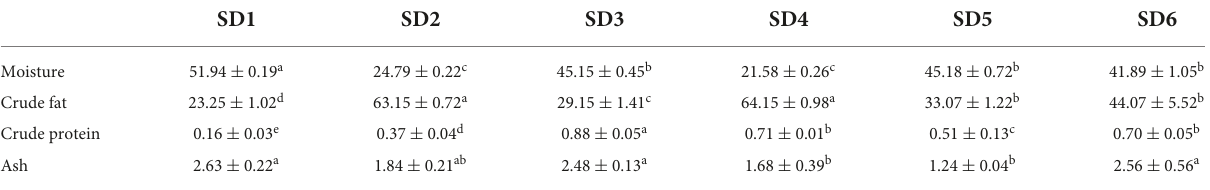
TABLE 3 Proximate composition of different sweet salad dressings